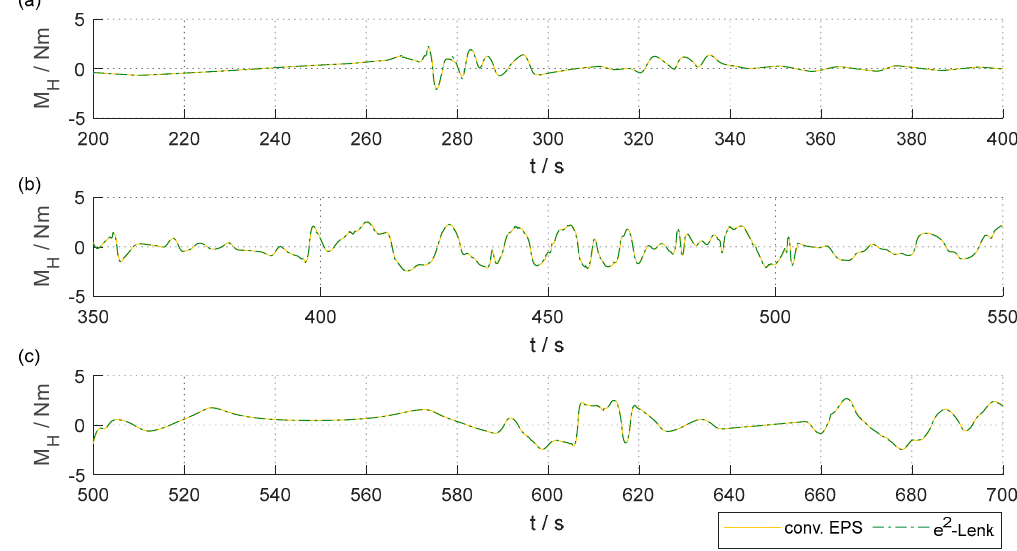
Figure 10. Excerpts of steering wheel torque over time: ( a ) Karlsruhe motorway, ( b ) Herzogenaurach highway and ( c ) within Karlsruhe.